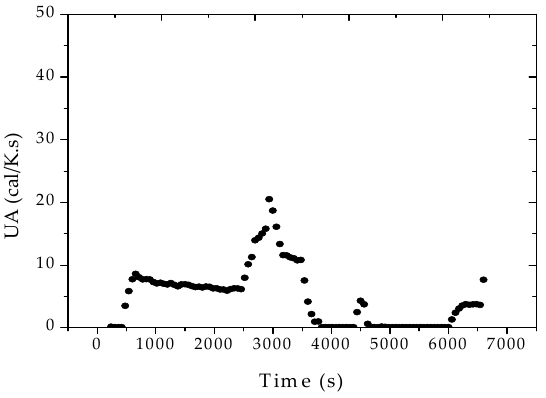
Figure 7. Reconciled UA profiles for reaction R3, considering the formation of fresh monomer droplets.